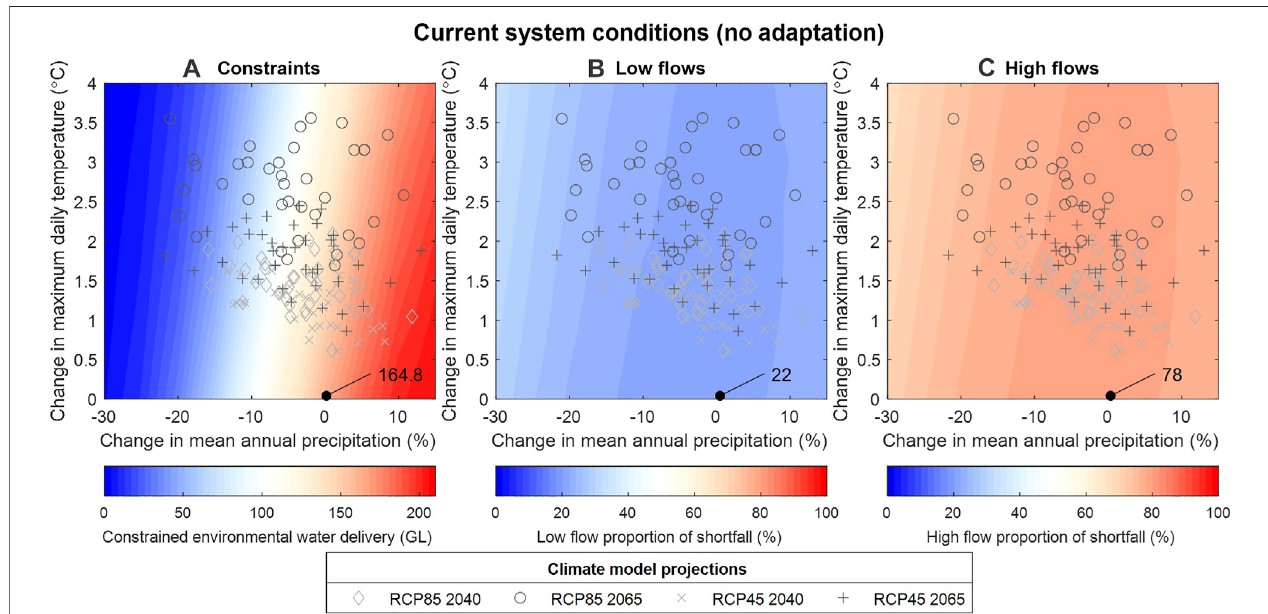
FIGURE 6 | Stress testing results for current system conditions showing: (A) constraints (allocated environmental water that cannot be delivered due to river capacity constraints); (B) and the low fl ow proportion of the environmental water shortfall; and (C) the high fl ow proportion of the environmental water shortfall.